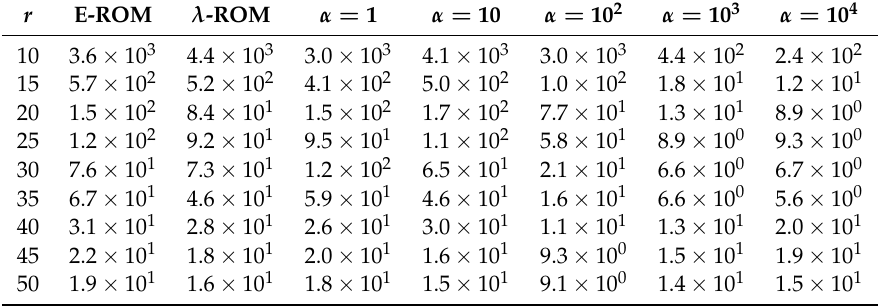
Table 5. Lagrangian investigation, predictive regime: L 2 norm of the errors in the time-averaged FTLE (23) for E-ROM (second column) λ -ROM (third column), and α -ROM for α = 1 (fourth column), α = 10 (fifth column), α = 10 2 (sixth column), α = 10 3 (seventh column), and α = 10 4 (eighth